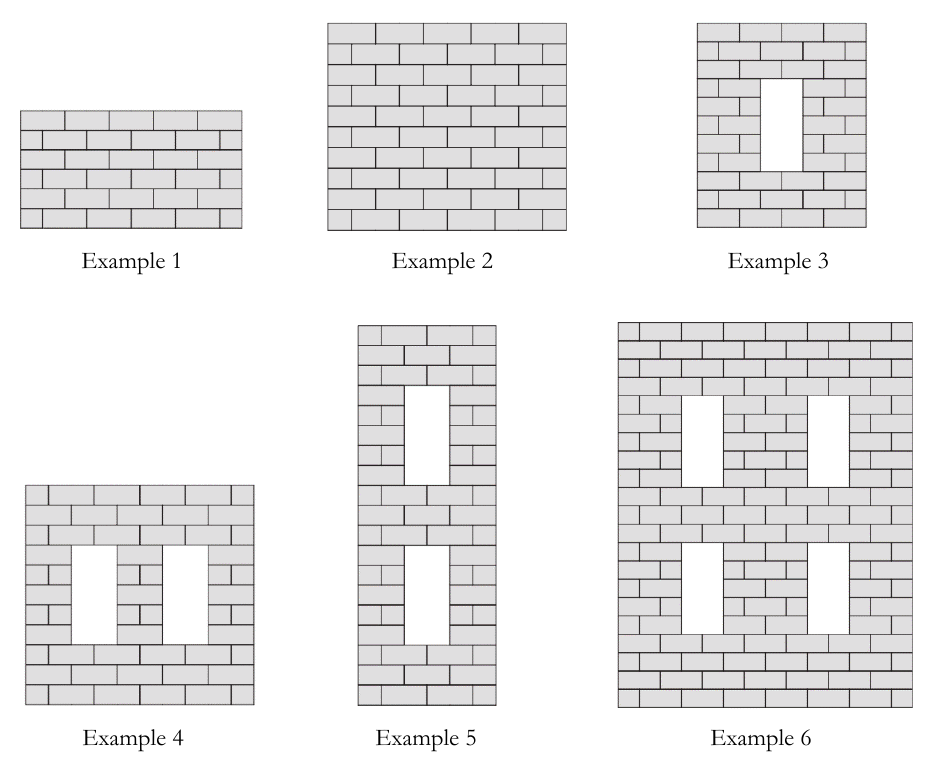
Figure 3: Geometrical configurations of the panels analyzed by Ferris and Tin-Loi